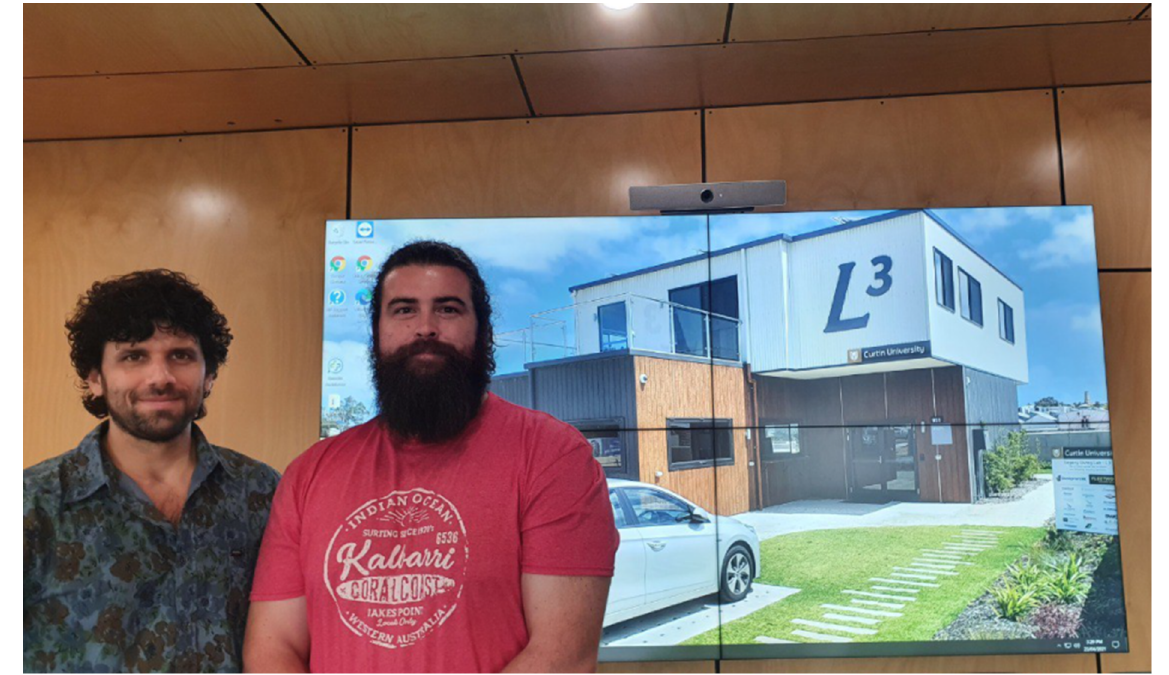
Figure 3. Dr Roberto Minunno ( left ) and Tim O’Grady ( right ) inside the Legacy Living Lab, showing it in its visualization space behind them.